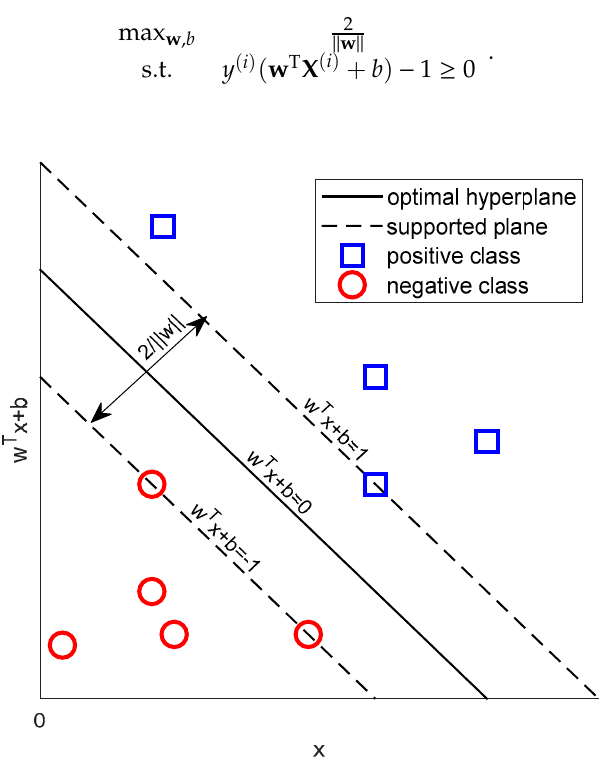
Figure 2. Hyperplane schematic diagram.